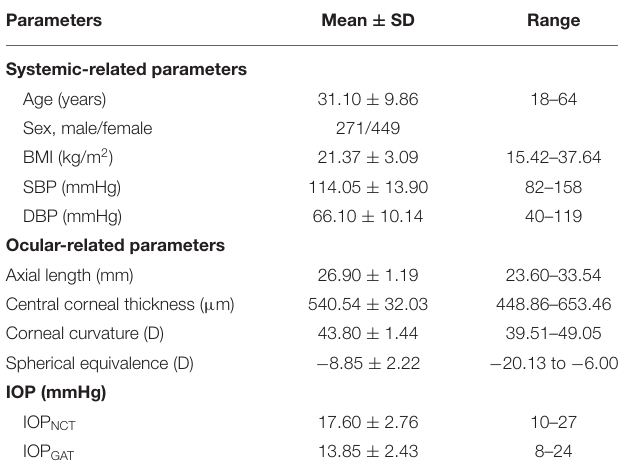
TABLE 1 | Demographic and ocular characteristics of the high myopia participants.